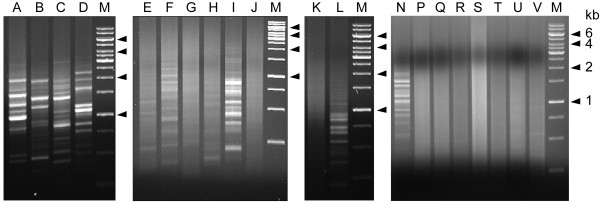
Amplicon range of inter-Alu PCR. The different lanes show gel electrophoretograms of amplicons obtained using different single primer or multiple primer sets: (A) AluJo56H16 alone; (B) AluJo232T16 alone; (C) AluSq56H16 alone; (D) AluSq263T16 alone; (E) AluJo56H16 and AluJo232T16; (F) AluJo56H16 and AluSq56H16; (G) AluJo56H16 and AluSq263T16; (H) AluJo232T16 and AluSq56H16; (I) AluJo232T16 and AluSq263T16; (J) AluSq56H16 and AluSq263T16; (K) AluJo56H16, AluSq56H16 and H-type L12A/8; (L) AluJo232T16, AluSq263T16 and T-type R12A/267, (N) AluY278T18, (P) AluY278T18 and AluY66H21, (Q)-(S) AluY278T18, AluY66H21 and R12A/267, (T) AluJo56H16, AluSq56H16 and AluSq263T16, (U) AluJo56H16, AluSq263T16 and AluJo232T16, (V) AluJo56H16, AluSq263T16 and L12A/8, and (M) M.W. markers. Notably, lanes E, G, H, J, P-V, where the inter-Alu PCR was performed using both H-type and T-type primers, gave rise to a largely smeared gel. Comparison of lanes N and P showed the conversion of a banded pattern obtained using a single T-type primer to a smeared one through the addition of an H-type primer. The much stronger staining intensity of lane S relative to lane R showed that the 0.30 μM concentrations of the same three primers in S compared to 0.10 μM in R resulted in increased amounts of amplicons. The primers AluJo56H16 (5'-GGCTCAAGCGATCCTC-3'), AluJo232T16 (5'-TATGATCGTGCCACTG-3'), AluSq56H16 (5'ACCTCAGGTGATCCAC-3'), and AluSq263T16 (5'-AACAAGAGCGAAACTC-3') were based on AluJo and AluSq consensus sequences [20]. H-type L12A/8 was an Alu consensus primer suggested earlier for inter-Alu PCR [15]. AluY278T18, AluY66H21 and T-type R12A/67 are described in Methods.